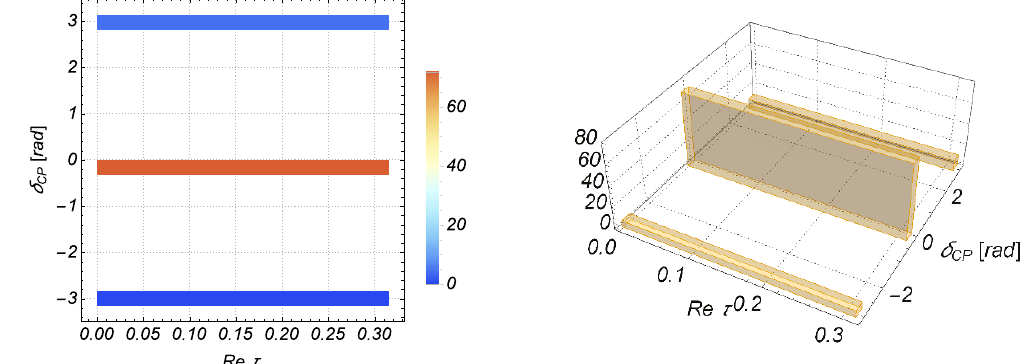
Figure 11 . Distributions of the CP-violating phase δ CP vs. real part of complex structure modulus Re τ for Im τ = 2 . 0 in Pattern III.